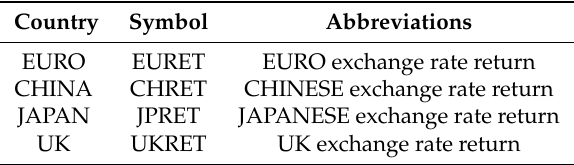
Table 2. List of countries and exchange